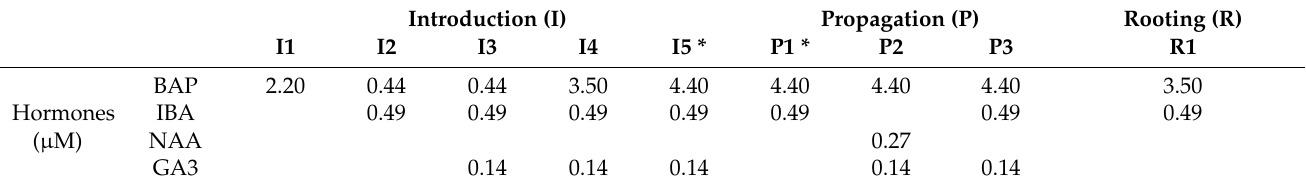
Table 1. Medium composition for in vitro clonal micropropagation platform of Leptocarpha rivularis . Murashige and Skoog medium, MS, with 3% ( w/v ) of sucrose, ascorbic acid (0.05 g/L), charcoal (1 g/L) and different hormone combinations. Hormones included are: 1-naphthaleneacetic acid (NAA), 6-benzylaminopurine (BAP), indole-3-butyric acid (IBA) and gibberellic acid (GA 3 ). * Indicates best medium